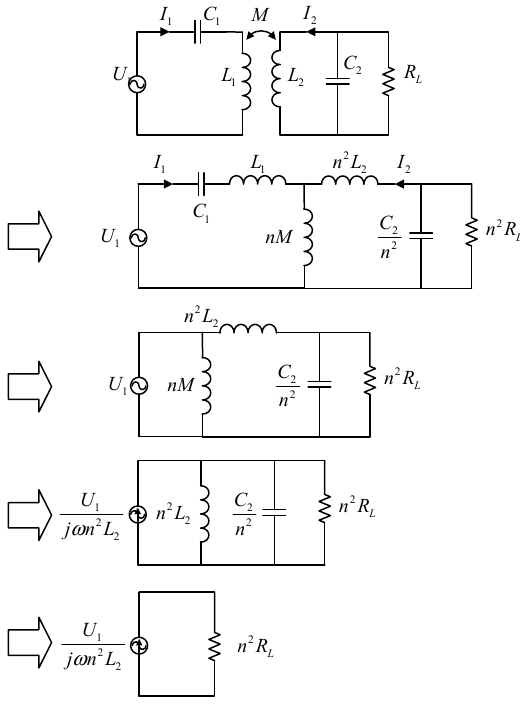
Figure 5. The SP compensation Witricity circuit using the equivalent circuit A.